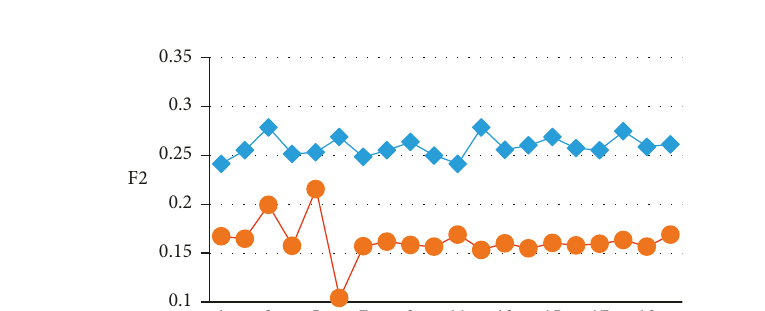
Figure 9: Threshold discrimination method based on F2.